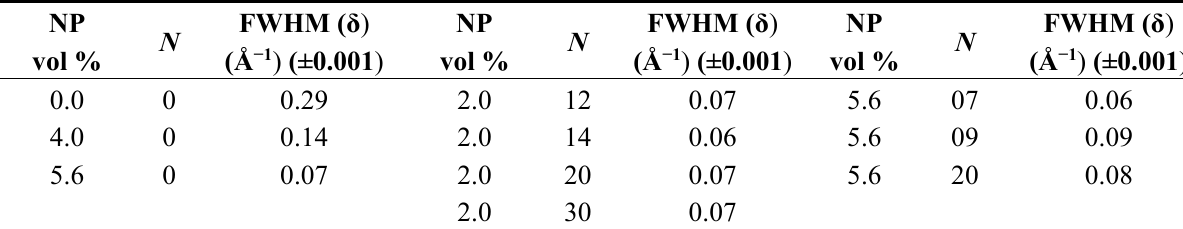
Table 2. X-ray peak widths for nanocomposite films as a function of N , the processing parameter and NP concentration in terms of volume percentage marked by vol